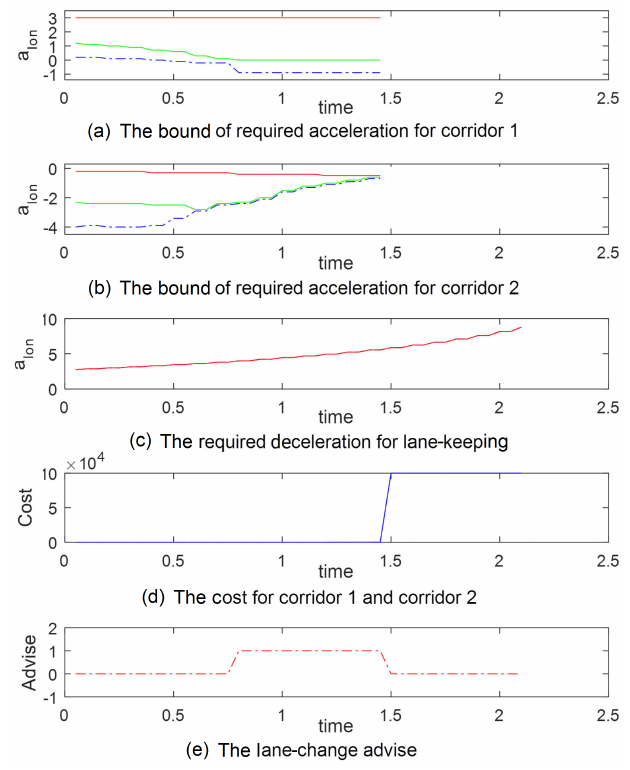
Figure 13. The maneuver evaluation result with a lon = 2 m/s 2 .